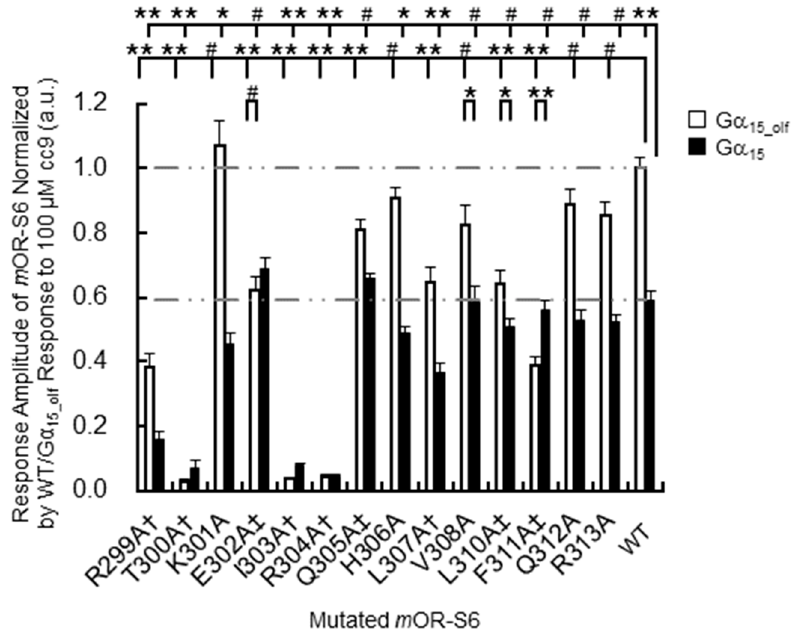
Figure 3. Scanning alanine mutations of m OR-S6 helix 8 and their associated calcium responses in a heterologous HEK293 system based in the average Ca 2+ responses to cc9 (from Reference [7] with permission for authors). Error bars indicate standard errors of the mean. Indiscriminate inactivation via G α 15_olf or G α 15 is indicated by † and selective inactivation via G α 15_olf or G α 15 , is indicated by ‡. Statistical significance was determined by the t -test and is labeled at the top of each bar (# p ≥ 0.01; 0.001 ≤ * p < 0.01; ** p < 0.001).